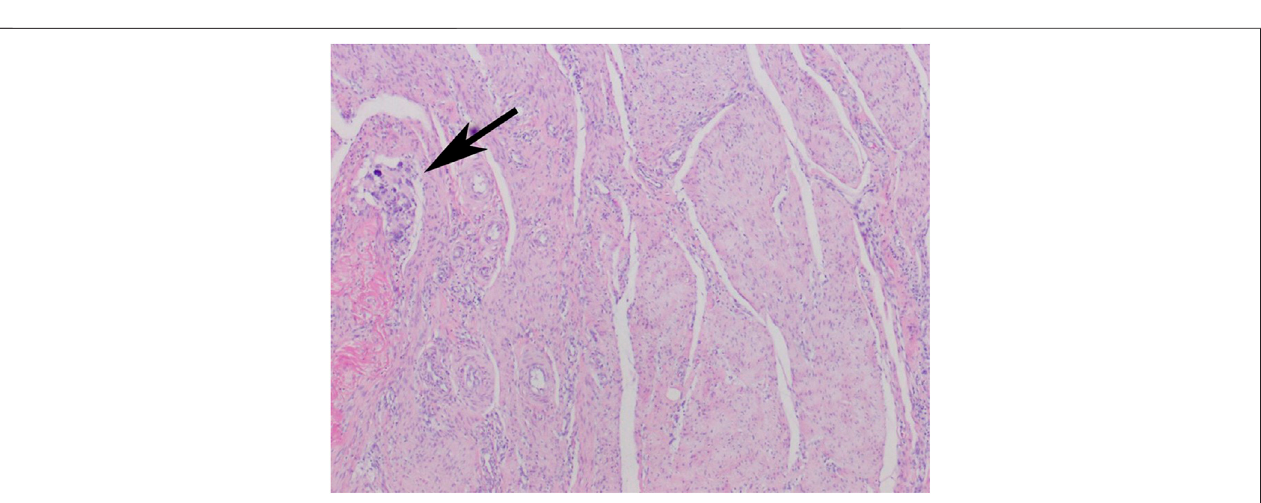
FIGURE 2 | Body integument. Fibrous scar tissue formed by thick collagen- fi broblastic bundles. Focal resorptive granuloma (arrow).